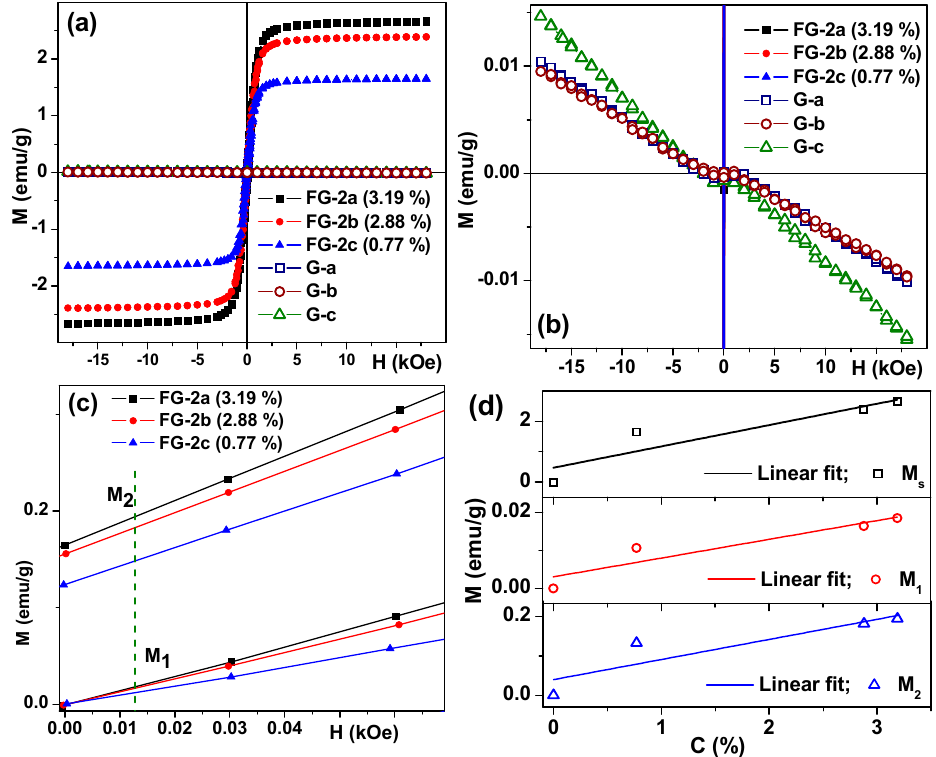
Figure 9. Magnetic properties of gels and ferrogels with magnetite particles. M(H) loops of gels/ferrogels in the field range in which the saturation tendency for ferrogels is observed ( a ). For FG-2 series the thickener was xanthan gum. M(H) loops of gels/ferrogels in low magnetic moment values scale for which the lack of the saturation tendency for gels is appreciated ( b ). Primary magnetization curves and close to remanence behavior for ferrogels: M 1 (for primary magnetization curve) and M 2 (for approaching remanence) values of the magnetic moments of ferrogels, green dashed line indicates magnetic field close to 12 Oe ( c ). Concentration dependence of M s and M 1 , M 2 parameters for FG-2 ferrogels ( d ).